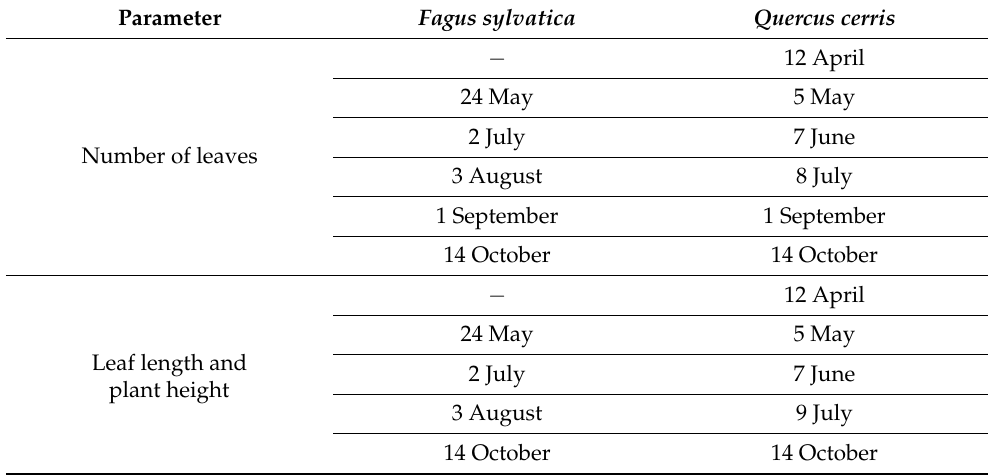
Table 5. Days on which the respective morphological parameters of Fagus sylvatica and Quercus cerris were measured. Parameter Fagus sylvatica